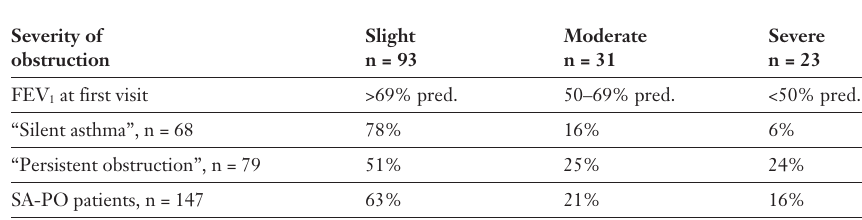
Figure 2 Variability of FEV 1 % pred. at four assessment times. “Silent asthma” (SA) and “Persistent obstruc- tion” (PO) patients with complete follow-up data, n = 76. FEV 1 % pred.: forced expiratory volume in 1 second expressed as percentage of predicted value. For each group, the distri- bution of the variable FEV 1 % pred. at different times is represented by four box plots, indicat- ing the minimum and the maximum values (end points of the two whiskers), the lower quartile (lower end of the box), the median (horizontal line within the box) and the upper quartile (upper end of the box). Observed me- dians: a) initial assessment: SA 80.0, PO 66.0, p = 0.002; b) post bronchodilator assessment: SA 93.5, PO 75.5, p = 0.0004; c) 1–3 months’ follow-up: SA 102.0, PO 79.5, p <0.0001; d) 2 years’ follow-up: SA 99.0, PO 75.0, p <0.0001. P-values obtained from